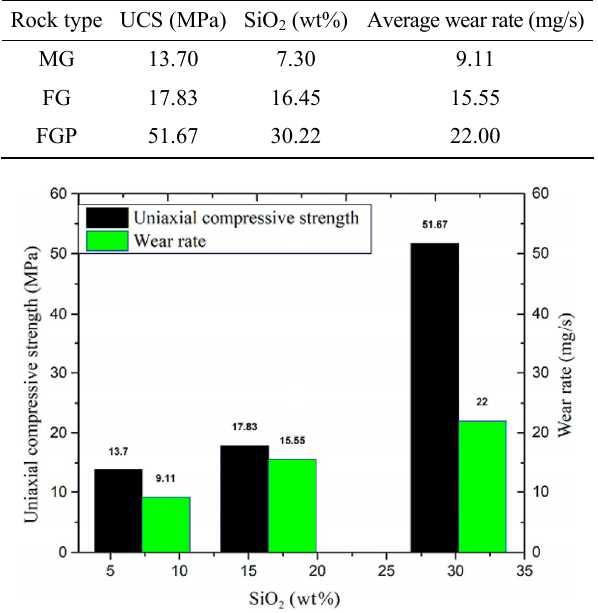
Fig. 4 Correlation of SiO 2 vs. wear rate and uniaxial compressive strength of the rock samples.